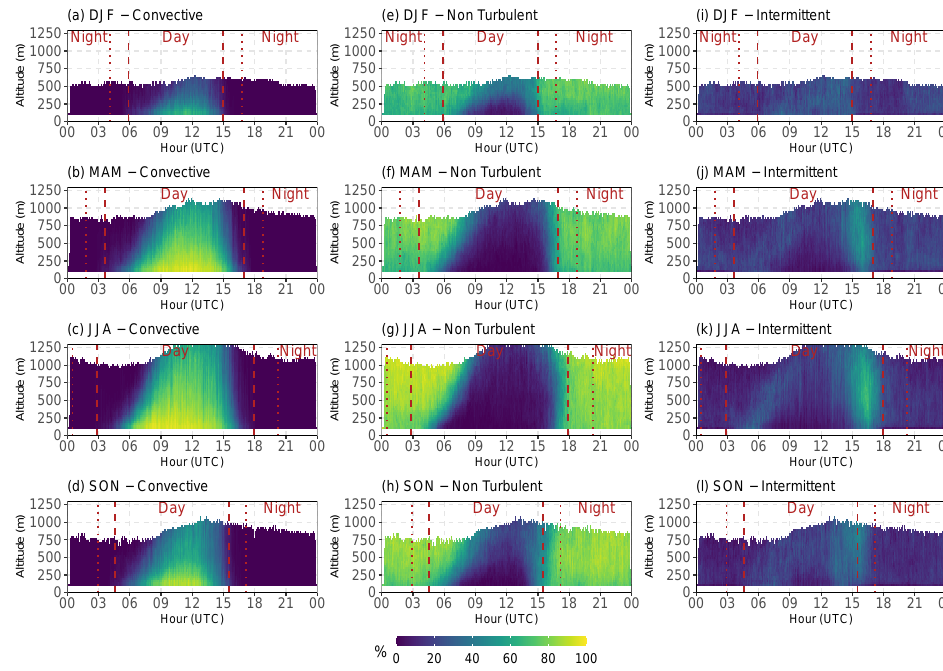
Figure 10. Frequency of occurrence for the three dominant PBL classes: Convective ( a – d ); Non Turbulent ( e – h ); and Intermittent ( i – l ) for each hour, range gate and season at Magurele